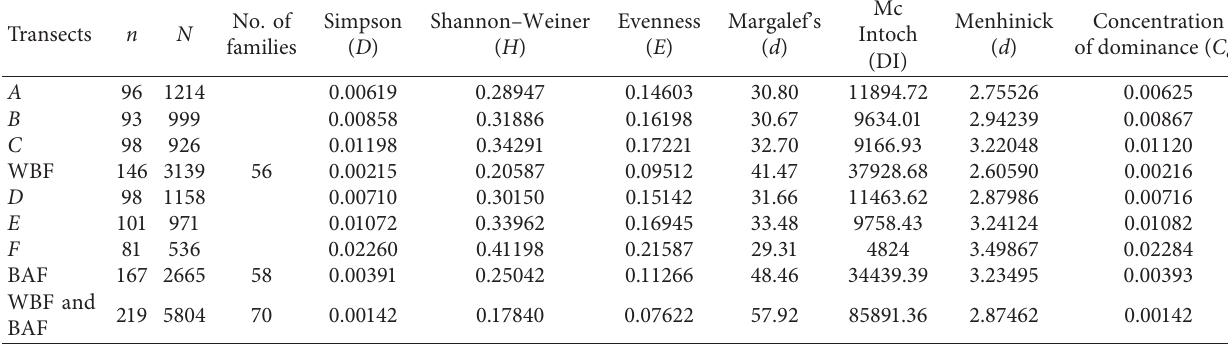
Table 1: Diversity indices of plants community at west bank forest and block A forest of IITA Transects